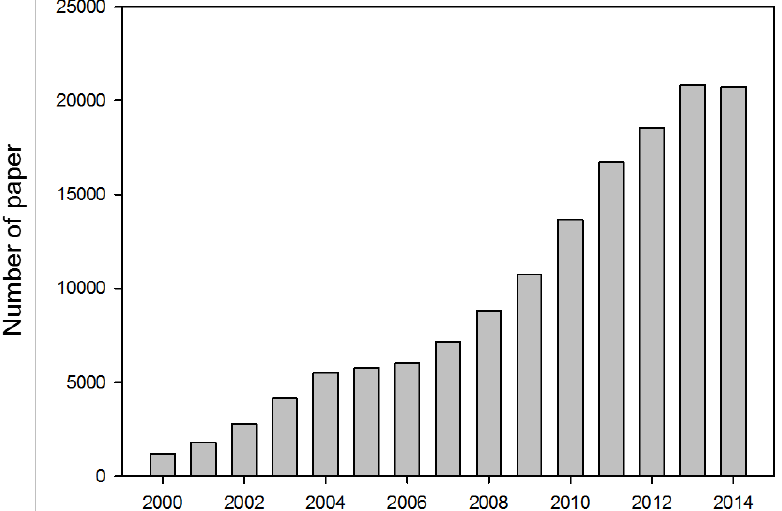
Figure 1. The number of nanoscience papers indexed in Scopus between 2000 and 2014. Source: “Nanoparticle”, data from